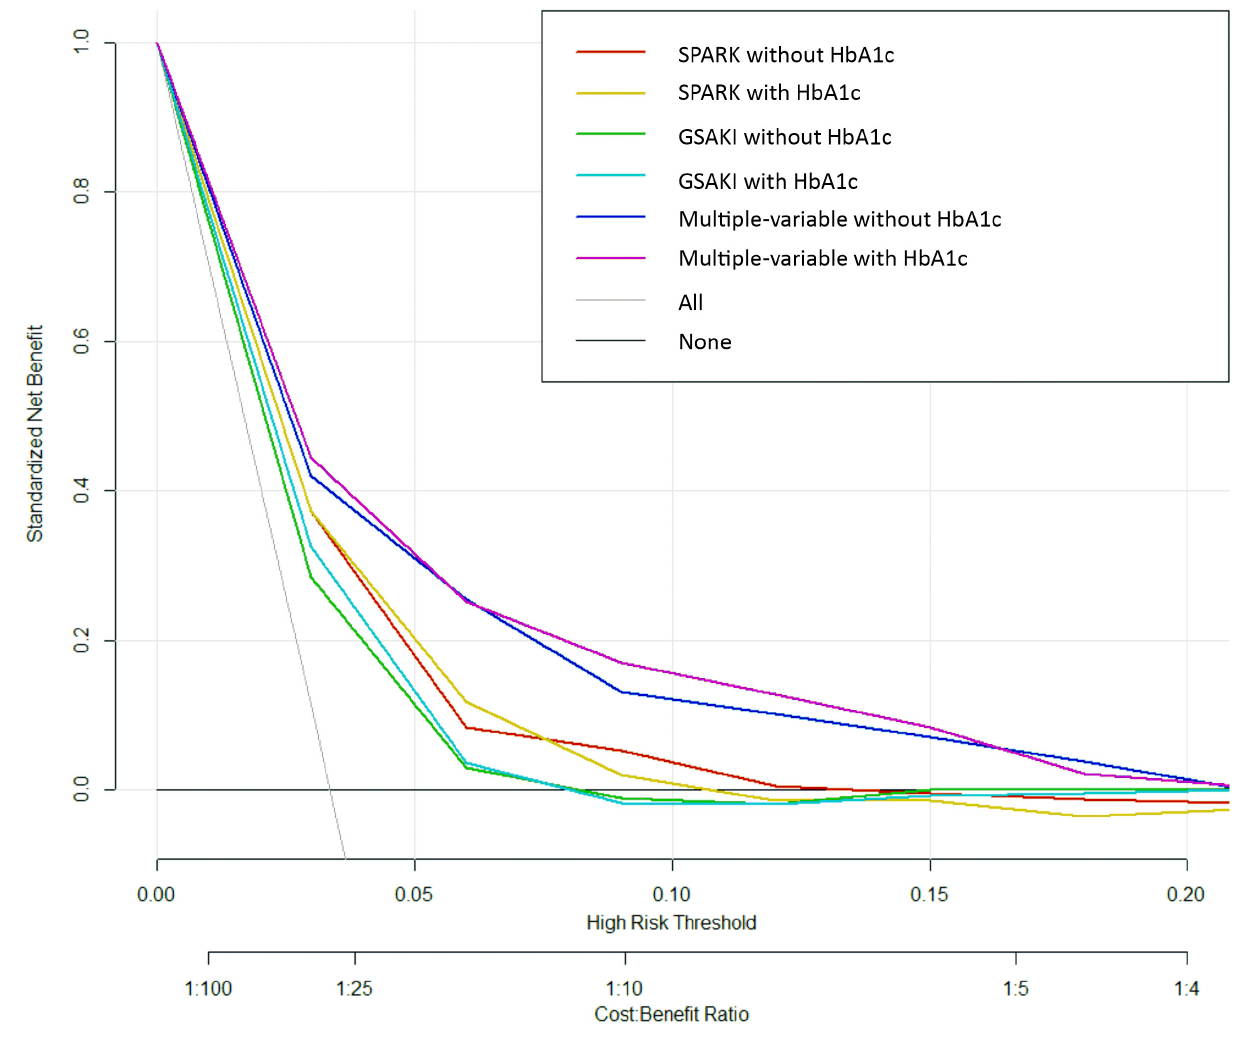
FIGURE 3 | Decision curve